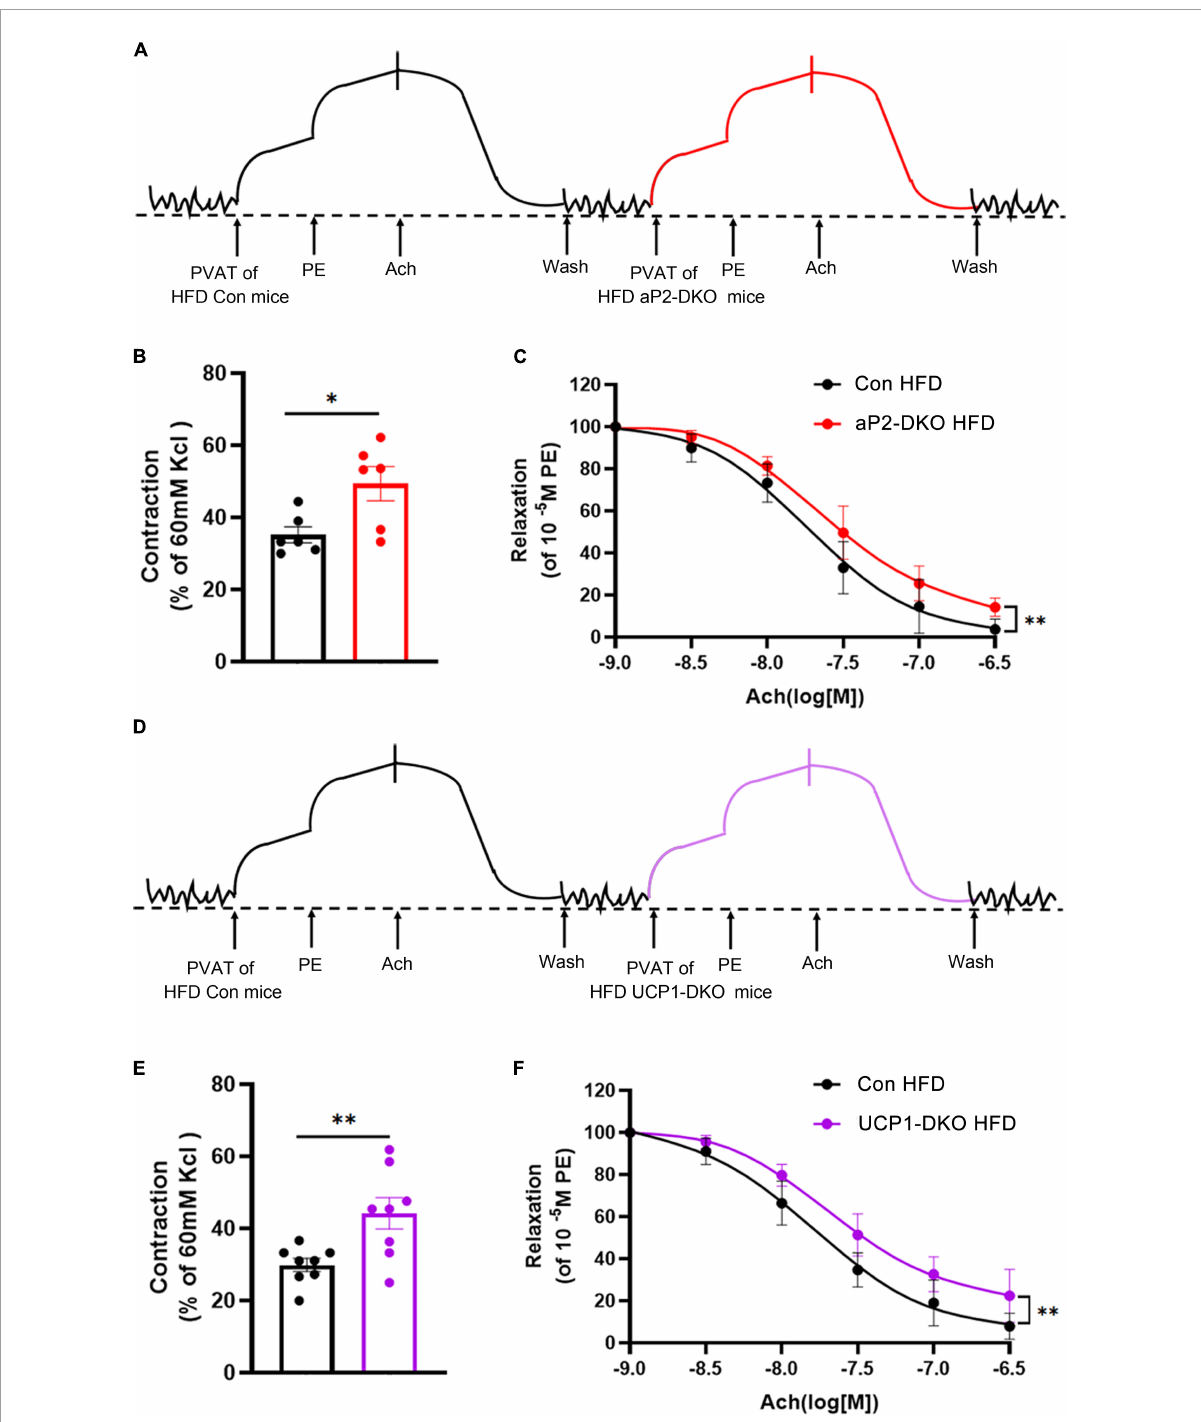
FIGURE5 Bone morphogenetic protein 4 (BMP4)-deficient PVAT induces vasoconstriction and endothelial dysfunction in vitro . PVAT extracts were collected from the control, aP2-DKO and UCP1-DKO mice with 12-week HFD. (A) Representative trace showing aortic ring reaction in response to different treatments. (B) Quantitative analysis of constriction tension of aortic rings in response to PVAT extracts. (C) Vasodilator response induced by ACh in aortic rings treated with PVAT extracts. (D) Representative trace showing aortic ring reaction in response to different treatments. (E) Quantitative analysis of constriction tension of aortic rings in response to PVAT extracts. (F) Vasodilator response induced by ACh in aortic rings treated with perivascular adipose tissue (PVAT) extracts. Values are means ± S.E.M. ∗ P < 0.05, ∗∗ P < 0.01, and ∗∗∗ P < 0.001 by unpaired Student’s t -test (B–E) or two-way analysis of variance (ANOVA) (C–F)